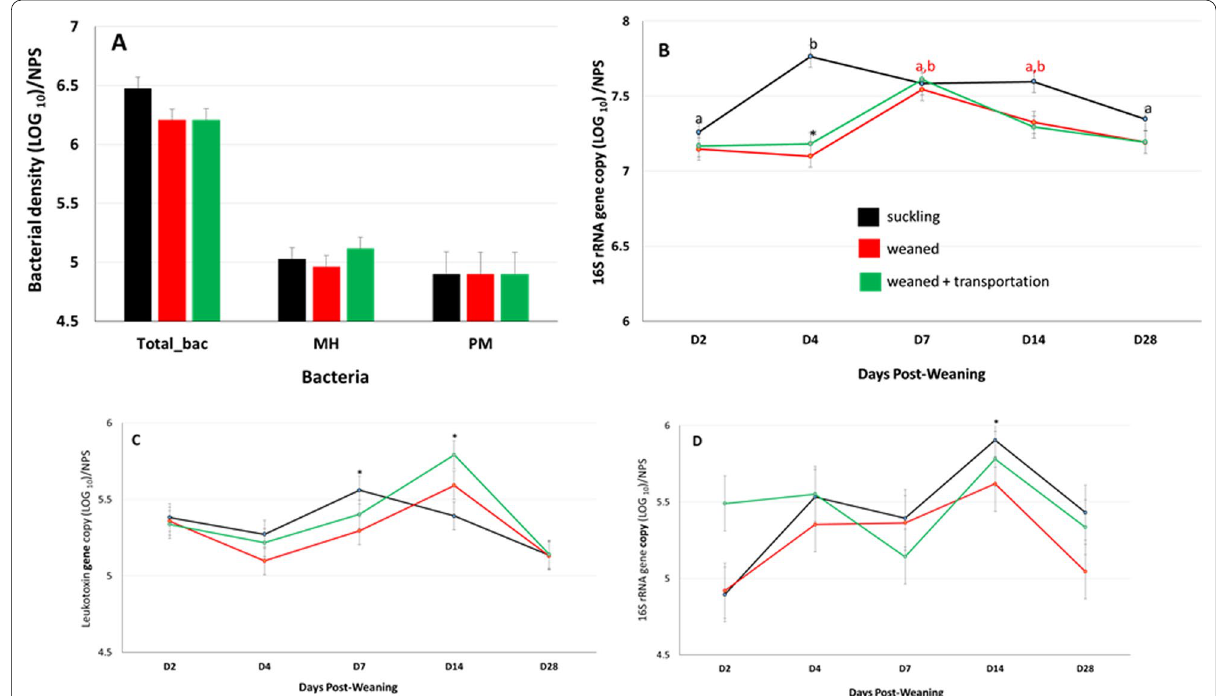
Fig. 4 Estimated bacterial densities in the URT of beef calves. A Bacterial densities at the time suckling calves were assigned to treatment groups. Total bacterial density (Total_bac) and P. multocida (PM) density quantified as 16S rRNA gene copy/swab. M. haemolytica (MH) density quantified as leukotoxin (Lkt) gene copy/swab. B Total bacterial density after allocation of calves to the respective treatment groups, ab—represents sampling points with significantly different bacterial densities ( P < 0.05) within suckling calves, *represents significant effect of weaning with or without transportation on bacterial density. C Density of M. haemolytica after allocation of calves to respective groups, *represents sampling points with significantly higher density of M. haemolytica . D Density of P. multocida after allocation of calves to the respective stressors, *represents sampling points with significantly higher density of P.